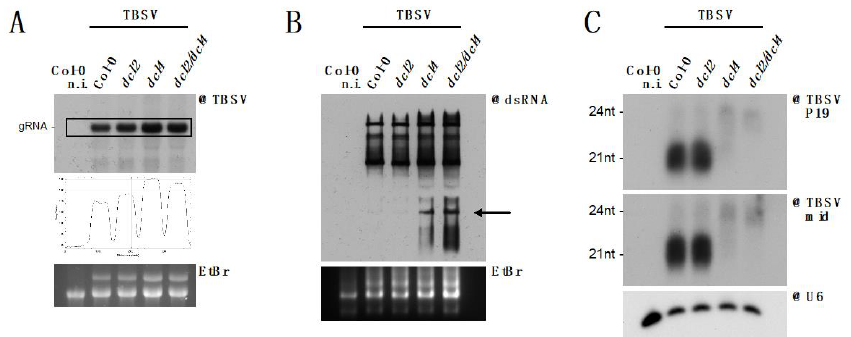
Figure 6. Processing of TBSV dsRNA by DCL4, but not DCL2, in A. thaliana . ( A ) Northern blot analysis of high molecular weight RNA to detect TBSV in systemically infected rosette leaves, 9 dpi, of A. thaliana mutant lines. Quantification of signal intensity is provided. Each sample is a pool of 4–5 plants. ( B ) Northwestern blot to detect dsRNA in the samples described in ( A ). The black arrow indicates the dsRNA band observed upon genetic knock-out of DCL4 . In ( A , B ) EtBr gel staining was used as loading control. ( C ) Northern blot analysis of low molecular weight RNA to detect TBSV-derived siRNA, using two separate probes. TBSV-mid detects siRNA derived from the 3′ end of the P92 ORF, while TBSV-P19 detects siRNA derived from the P19 ORF. As a loading control, the membrane was separately hybridized to a snU6-specific probe. In all the blots a non-infected control (n.i.) was included on the far left.